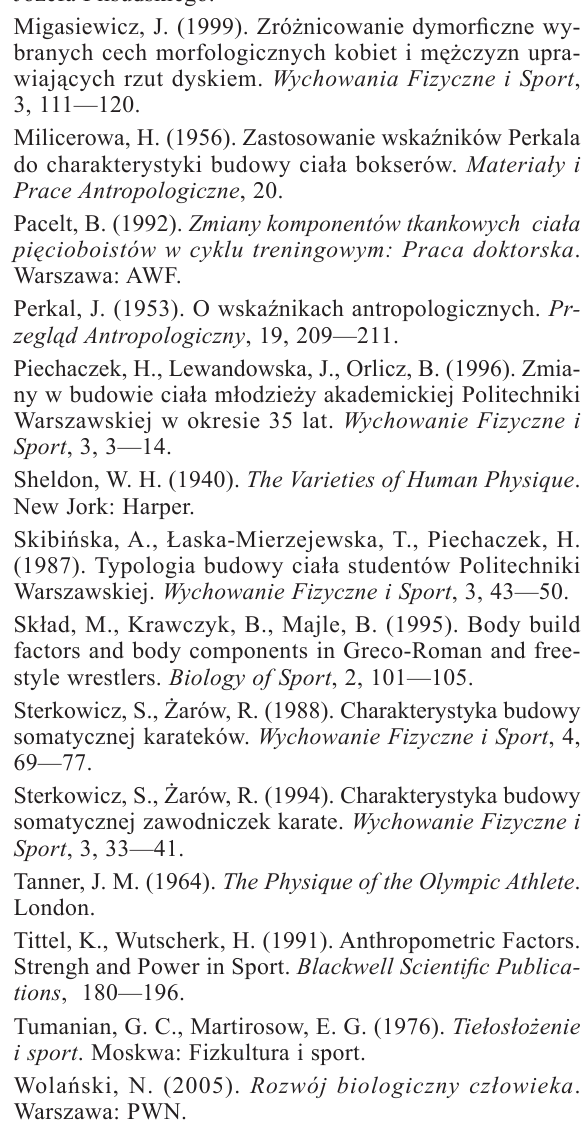
4. Natural indices of features within the stou- tness factor revealed the prevalence of the fo- rearm perimeter (1.62) and elbow width (0.36). The knee width (–1.30) and pelvis width (–0.60) are disproportionate to the overall value of his factor. The input of features characterizing the length factor is relatively